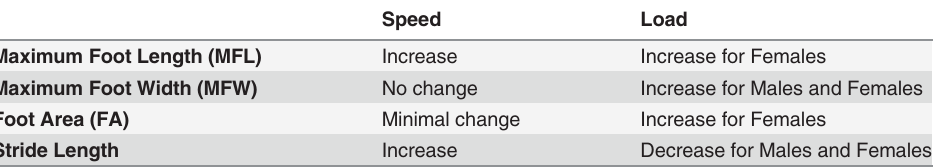
Table 1. A summary of signi fi cant changes (p < 0.05) to footprint size and stride length during loaded